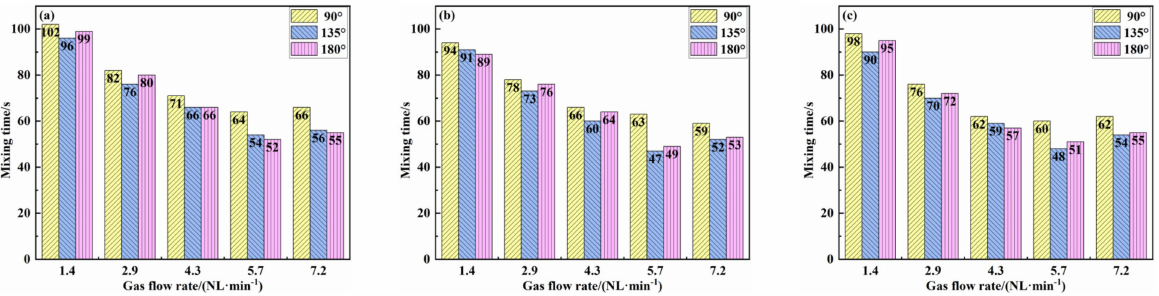
Figure 4. Effect of gas flow rate on MT at various radial location: ( a ) 0.43R; ( b ) 0.6R; ( c )